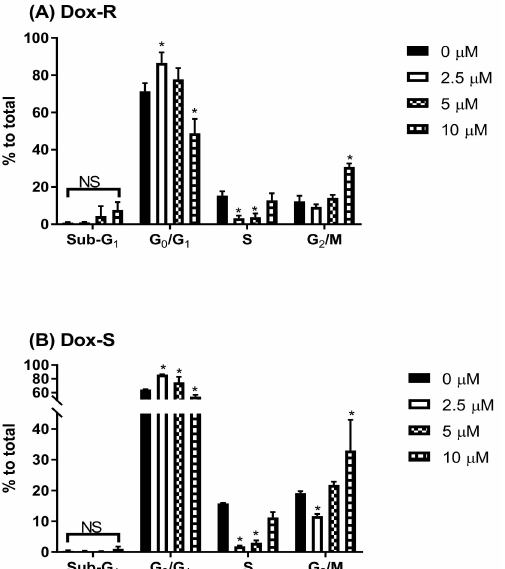
Figure 2. Cell cycle change in Dox-R and Dox-S cells after PG treatment. ( A ) Dox-R and ( B ) Dox-S cells were treated with PG for 24 h, respectively, and stained with propidium iodide for DNA content measurement. Results were shown as mean ± SD from 3 independent experiments. * and NS indicated “ p < 0.05” and “not significant” when compared with untreated control, respectively.